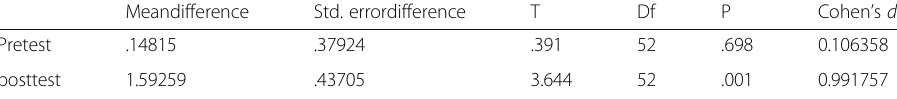
Table 6 Independent samples t-tests on reading comprehension pretest and posttest